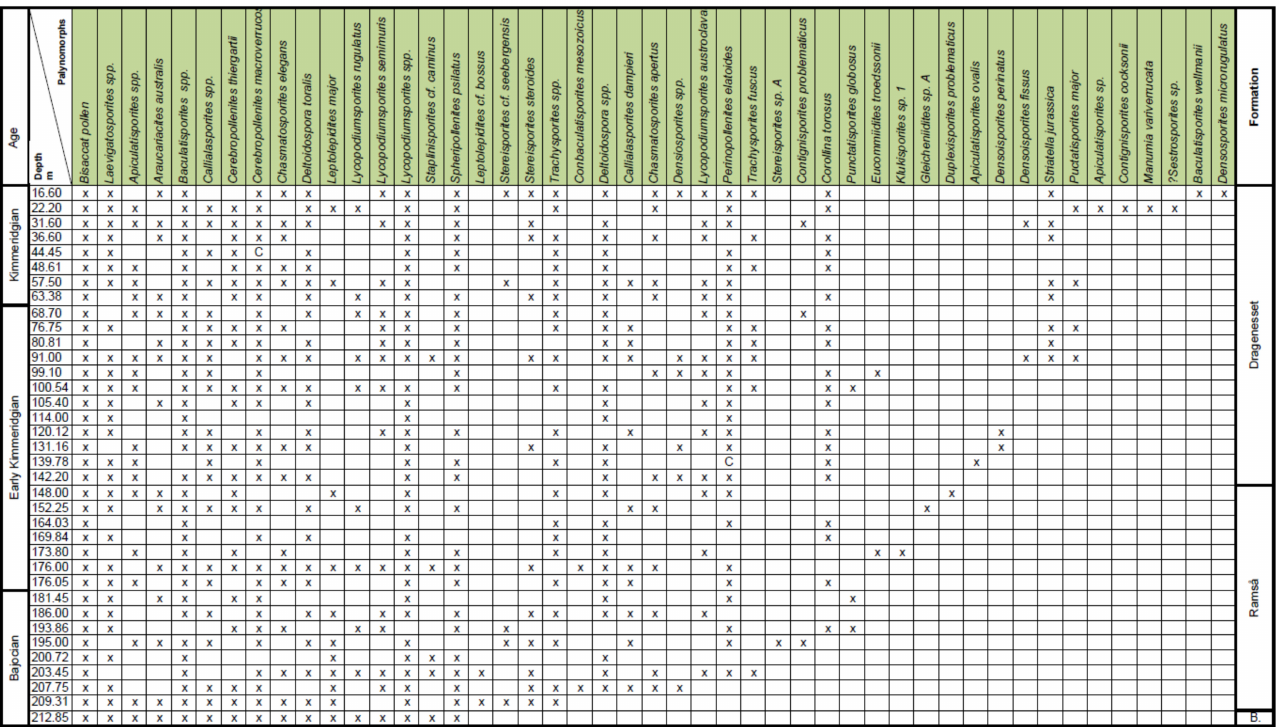
Figure A5. Records of terrestrial palynomorphs in borehole Bh